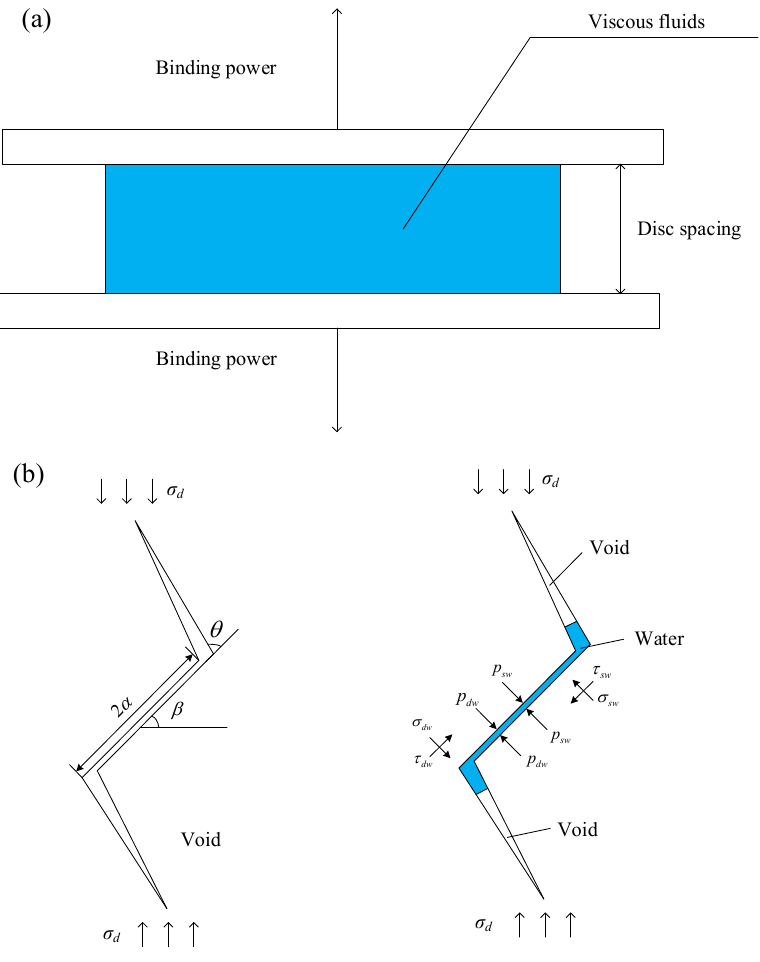
Figure 29. Schematic representation of the effect of water on the dynamic expansion characteristics of cracks in coal. ( a ) Schematic of the Stefan effect. ( b ) Dynamically loaded free water forces on fracture surfaces.